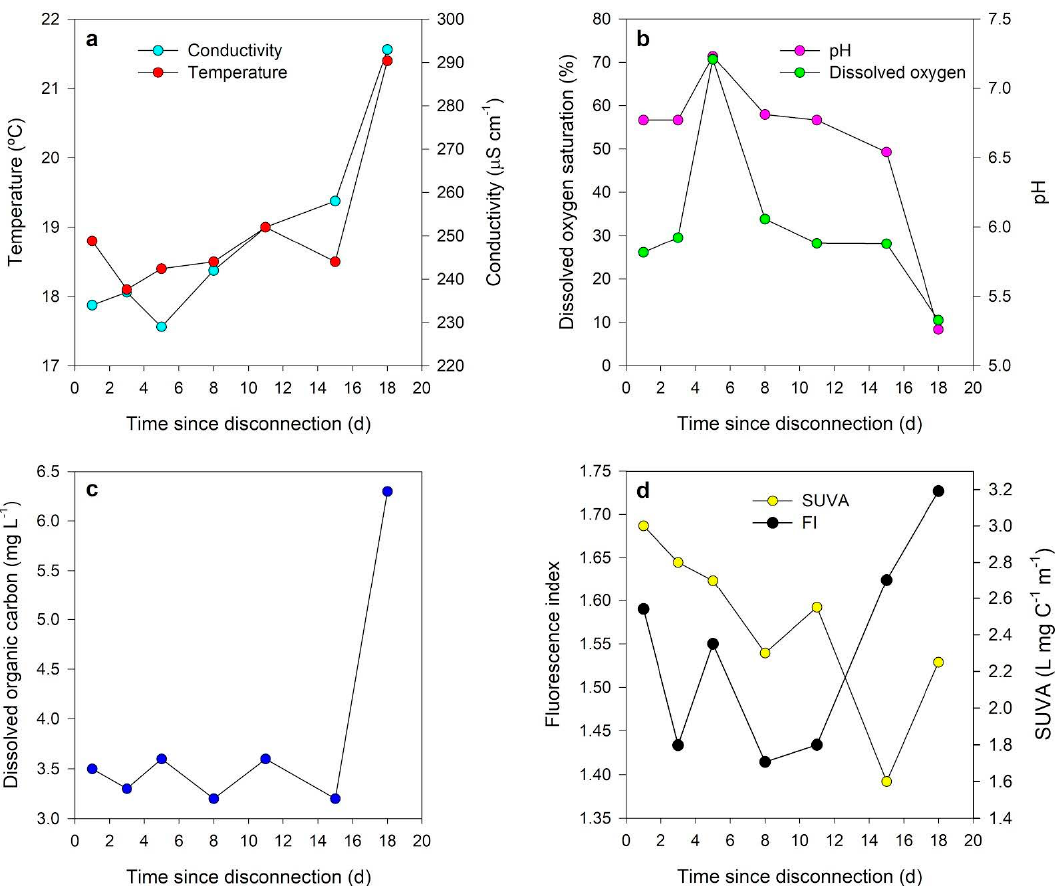
Figure 4. Temporal variation (i.e., time since disconnection in days), ( d ) of key physicochemical variables and dissolved organic matter (quantity and composition) in the surface water of an isolated pool (Fuirosos river, Catalonia, NE Spain). ( a ) Temperature and conductivity. ( b ) Dissolved oxygen saturation and pH. ( c ) Concentration of dissolved organic carbon. ( d ) Two indexes of DOM composition: Fluorescence index and specific ultraviolet absorbance (SUVA). The largest shift in most variables occurred just before complete surface drying (day 18). A short flow pulse on day 4 reconnected the isolated pool for 3 days, causing changes in some of the shown variables.